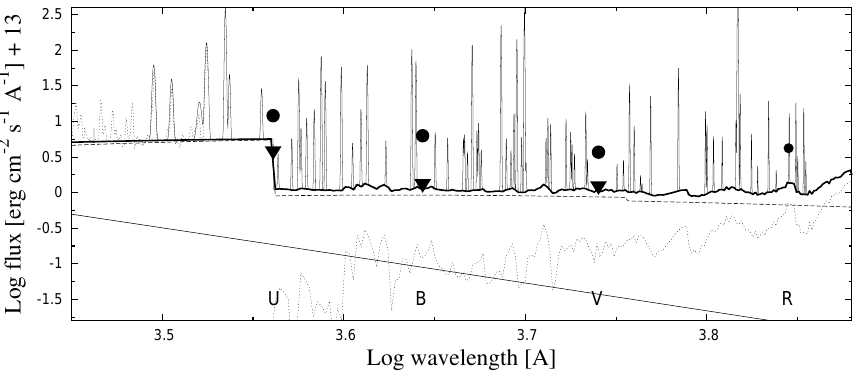
Fig. 3. Reconstructed SED in the near-UV/optical continuum of the symbiotic nova V1016 Cyg. The solid thin line represents radiation from the hot object ( T h = 150 000 K), the dashed line represents the radiation from the nebula ( T e = 16 800 K) and the solid thick line represents the resulting modeled continuum. The radiation from the giant was compared with the synthetic spectrum and scaled to the flux in the J band (see the text). The emission-line spectrum was introduced in Fig. 2. Full circles represent fluxes obtained from the broad-band photometry. Triangles are the U , B and V magnitudes corrected for the emission